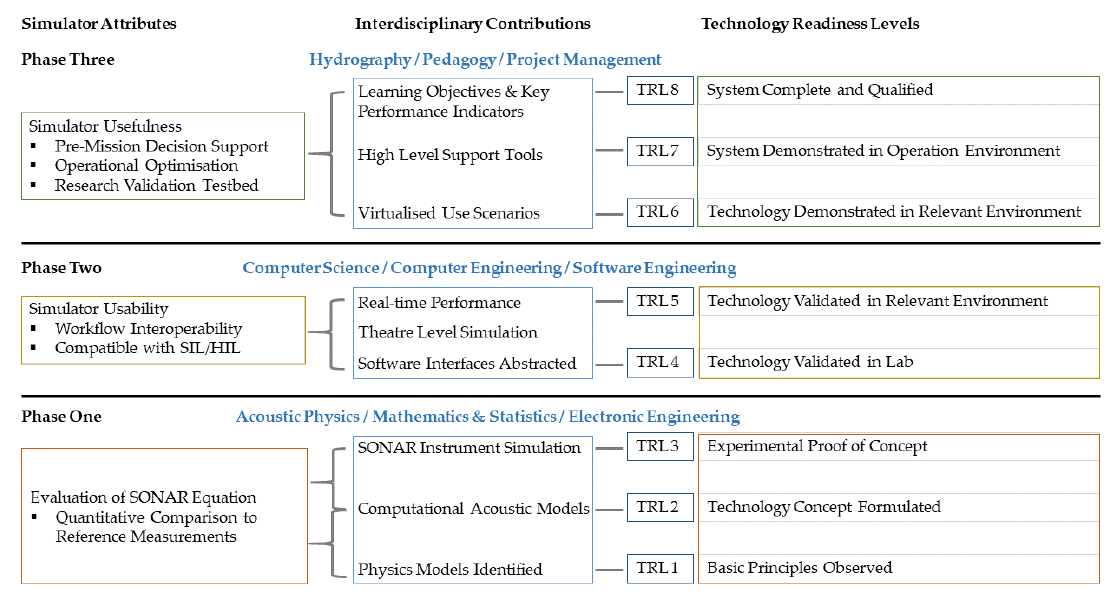
Figure 1. The three key phases in the simulator development in terms of functional and non-functional attributes, the interdisciplinary contributions required to meet acceptance criteria at each phase, and their mapping to the conventional definition of technology readiness levels.